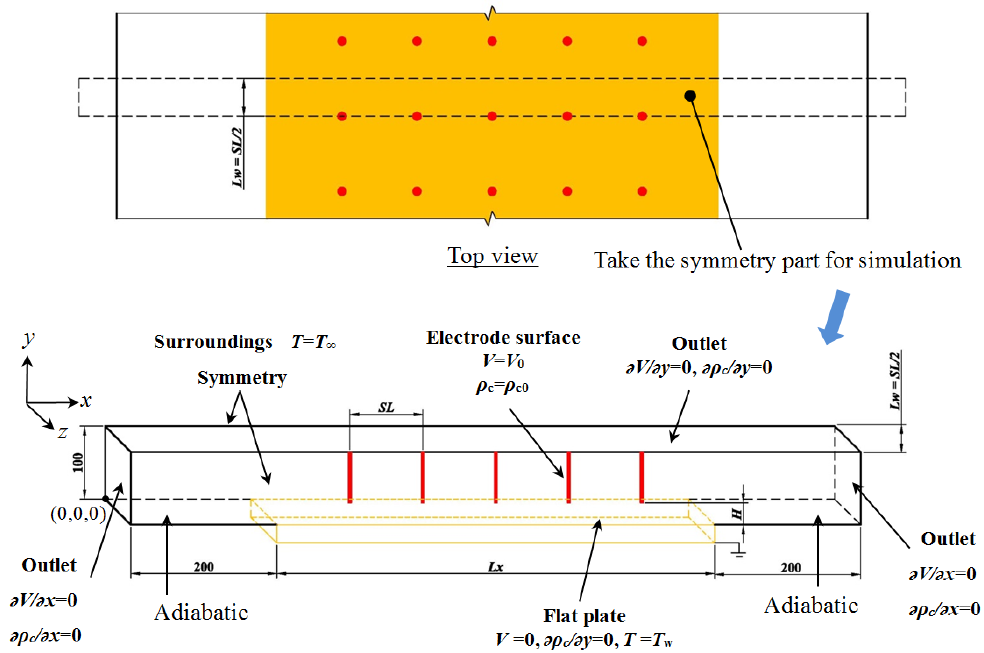
Figure 1. The physical model and boundary conditions.